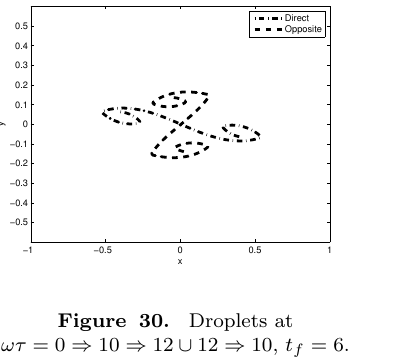
Figure 31. β ( l ) stac for ωτ = 0 ⇒ 10 ⇒ 12 ∪ 12 ⇒ 10, t f =